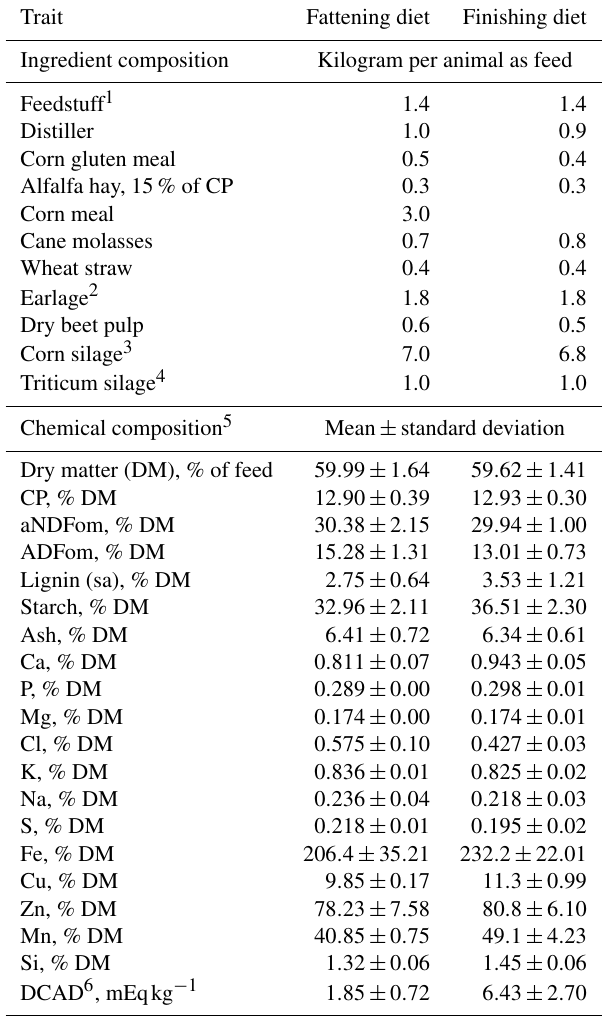
Table 2. Ingredients (kg per animal as feed) and chemical compo- sition (mean ± standard deviation) of fattening and finishing beef cattle total mixed rations administered during the